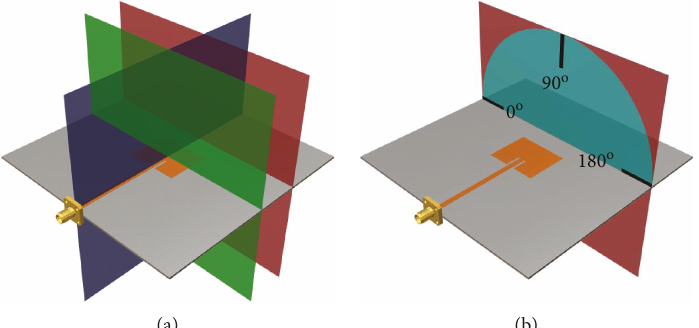
Figure 2: Antenna planes: (a) E -plane (blue), H -plane (green), and simulation/measurement plane (red) o ff set from the H -plane by 20mm; (b) simulation/measurement plane angle range of interest